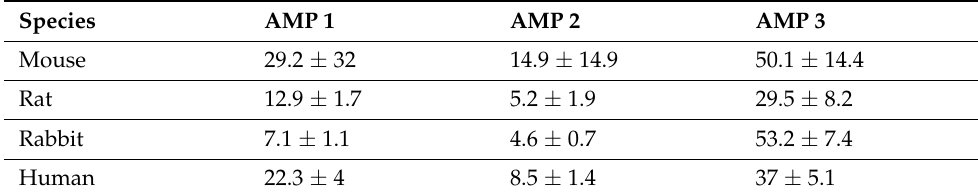
Figure 1. OD measurements at 405 nm (Y-axis) of free hemoglobin in a 1% erythrocyte solution originating from a mouse, rat, rabbit, and human, incubated for 60 min at 37 °C with PBS (negative control), 10% Triton X-100 (positive control), or AMPs 1, 2 or 3 (at concentrations of 100 µ M). Average values from three experimental replicates, each containing two technical replicates, are presented with error bars (SD) included in plots. Significantly different data as defined from unpaired t -test is indicated by asterisks for comparison of human and rabbit samples ( p -values: * < 0.05 *** < 0.001 **** < 0.0001 ns: non-significant). See Table S1 for p -values from comparison of all species. Table 1. Calculated hemolysis ratios (in %) according to Equation (1) for AMPs 1, 2, and 3 (100 µM) when using 1% mouse, rat, rabbit, and human erythrocyte solution. Normalization was performed on data averaged from three experimental replicates each containing two technical replicates using 10% Triton X-100 and PBS samples as positive and negative controls, respectively.